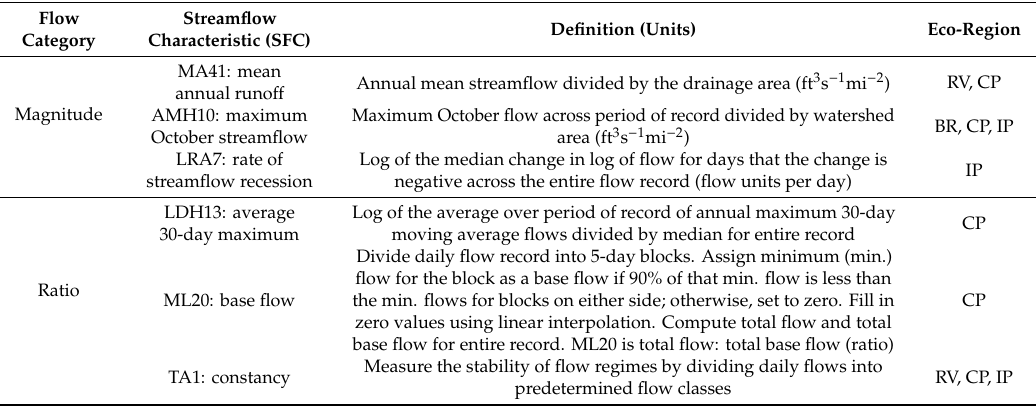
Table 1. Definitions of streamflow characteristic (SFC) used in ecological limit functions and the respective ecoregion(s) where they were found to be statistically significant; modified from